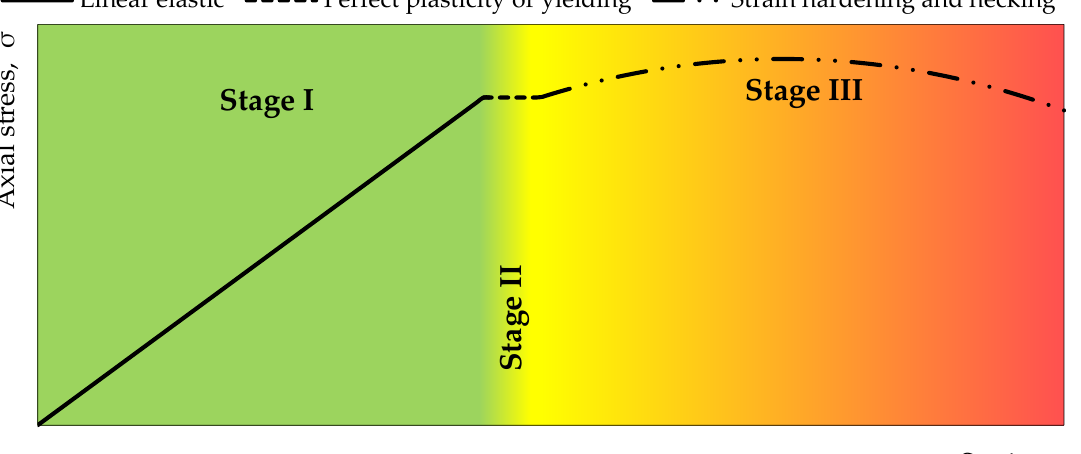
Figure 7. Stress-strain curve for steel used during the manufacturing of instrumented rock bolt.